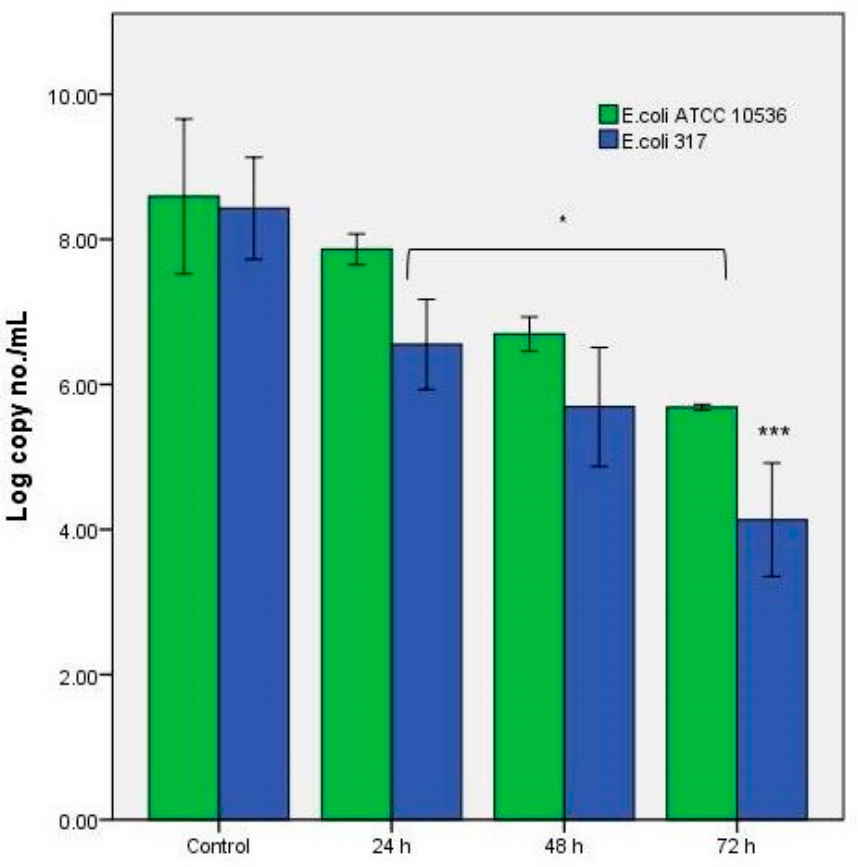
Figure 2. The antibacterial effect of the product in the in vitro catheterization system. Different asterisks represent significant statistical differences (control vs. samples; p ≤ 0.05), n = 3 .